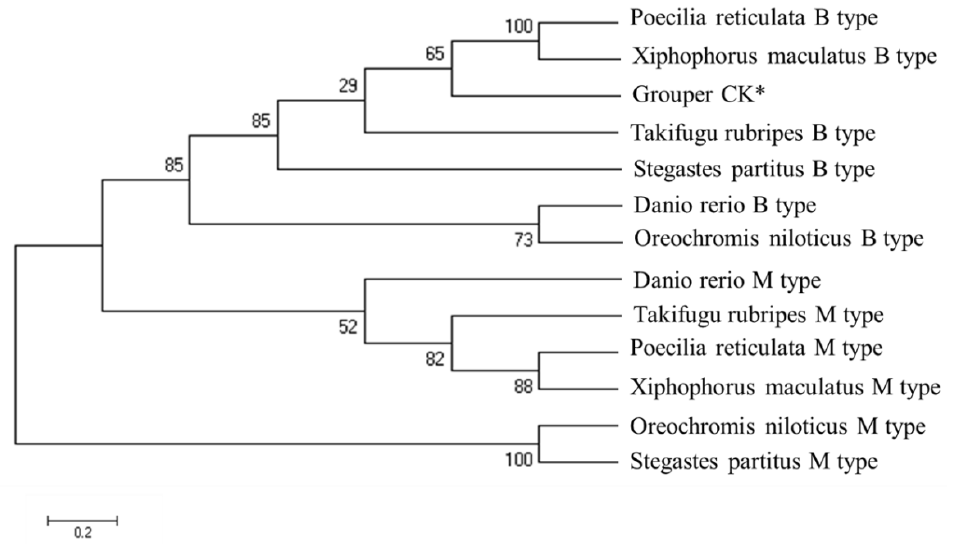
Figure 2. The sequence and phylogenetic analysis of grouper CK. The sequence and phylogenetic analysis of grouper CK. ( A ) the nucleotide sequence and deduced amino acid sequence. ( B ) The phylogenetic tree was constructed by the neighbor-joining method and shows relatedness of 12 CK fish organisms. Robustness was tested by 1000 bootstrap replications and the indicated distance given the value of 0.1 means the 10% differences in amino acid residues between compared sequences. Bootstrap values are given in percentages. * represents the grouper CK sequence used in this study.